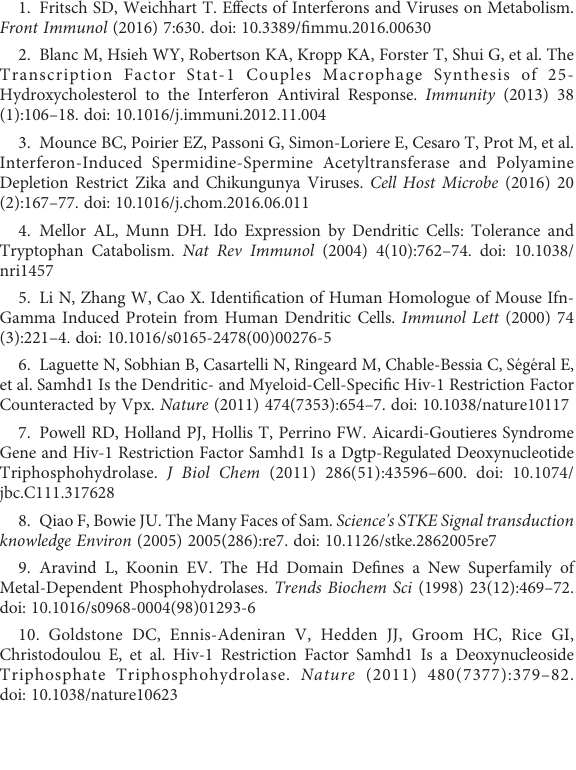
SUPPLEMENTARY FIGURE 1 Effects of SAMHD1 truncations on the formation of LDs. Huh7.5.1 cells with extrogenous SAMHD1 truncations [SAMHD1(45 – 626), SAMHD1(112 – 626), and SAMHD1(1 – 582)] overexpressing were measured by immuno fl uorescence staining. LDs, SAMHD1, and nucleus were respectively stained with BODIPY493/503 (green), anti-myc antibody (red), and DAPI (blue). Representative images are shown. Bars, 5 m m. SUPPLEMENTARY TABLE 1 Genome-wide gene expression pro fi le analysis of SAMHD1 overexpressing Huh7.5.1 cells SUPPLEMENTARY TABLE 2 Description of genes associated with lipid metabolism in Figure